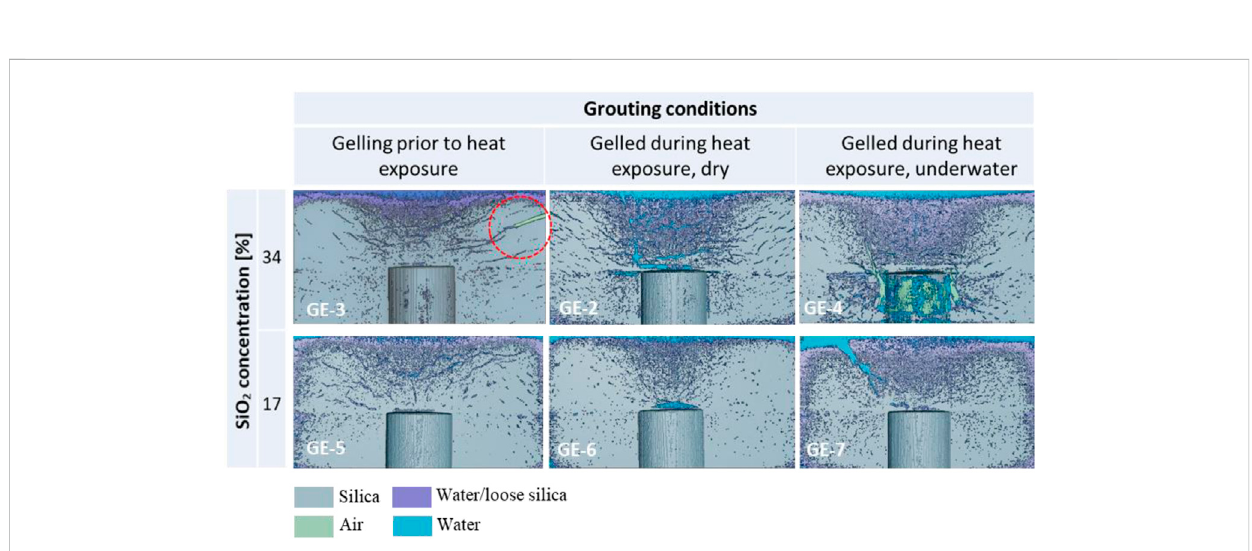
FIGURE 11 Vertical cross-section passing through the centre of the 3D reconstructed volume obtained via X-ray tomography, at the end of GE-2 to GE-7. Please refer to the supplementary material to access the 3D visualisation of the reconstructed